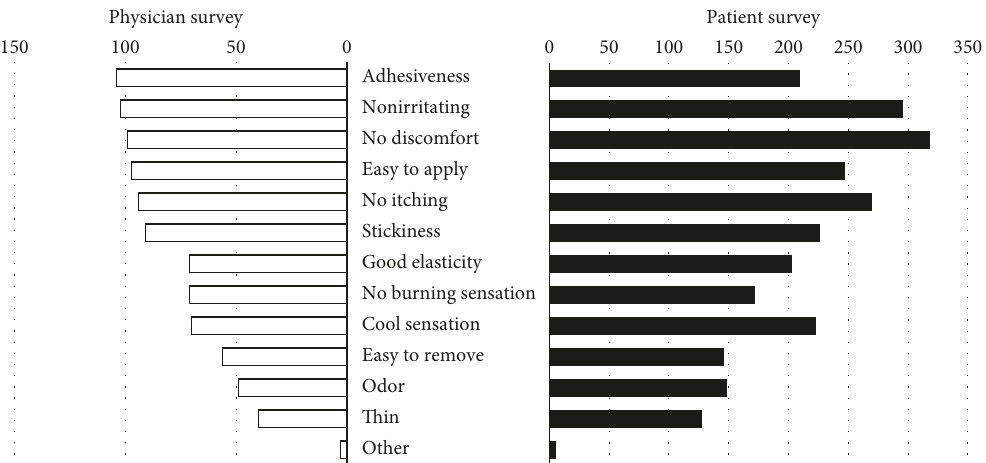
Figure 5: Concepts associated with “comfort” when applied (multipleresponses allowed: physician survey ( n (cid:136) 200) and patient survey ( n (cid:136) 600)). Nonirritating, no discomfort, easy application, and no itching sensation were highly reported among both physicians and